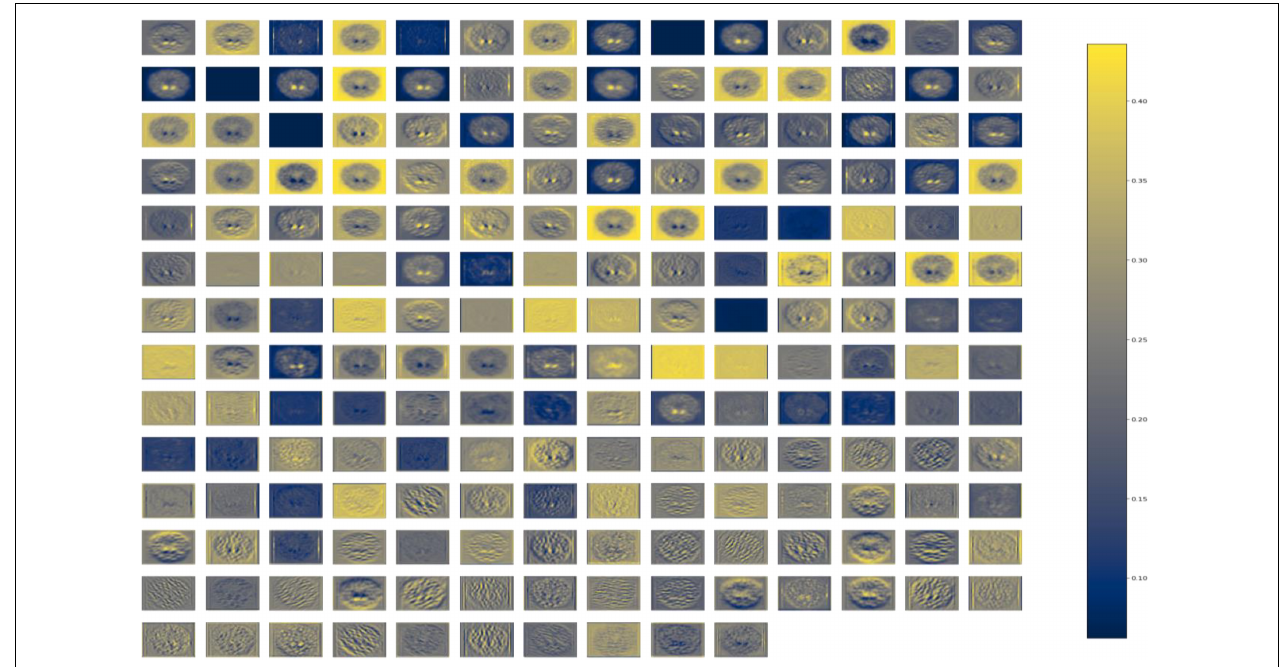
FIGURE 9 | Dense Block of DenseNet121 with batch normalization